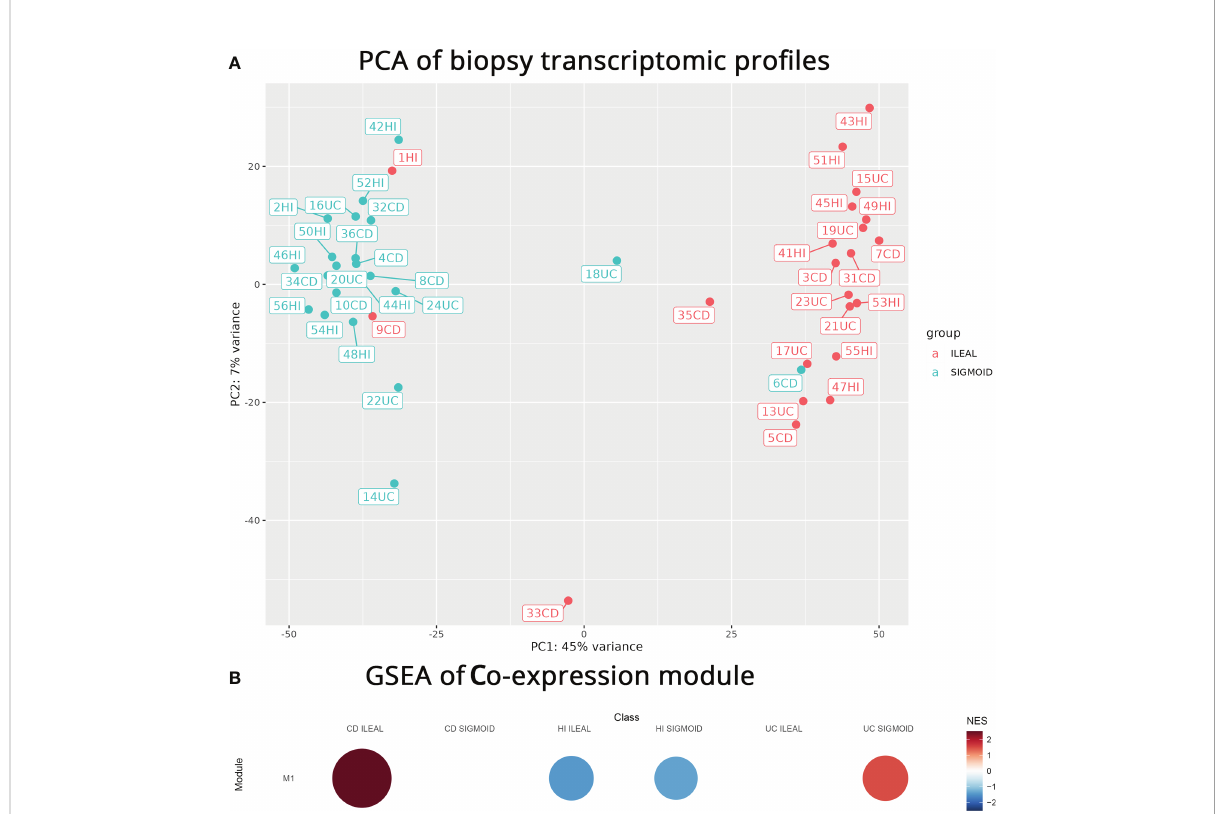
FIGURE 4 (A) PCA plot of our mRNA sequencing data colored according to biopsy location. Biopsy location explains a very large part of the variance. (B) Gene set enrichment analysis (GSEA) plot, generated with CEMiTool, showing the correlation of the co-expression module to speci fi c disease and intestinal segment combinations. Red and blue colors denote over- or under-expression, respectively. Size depicts the strength of the correlations.